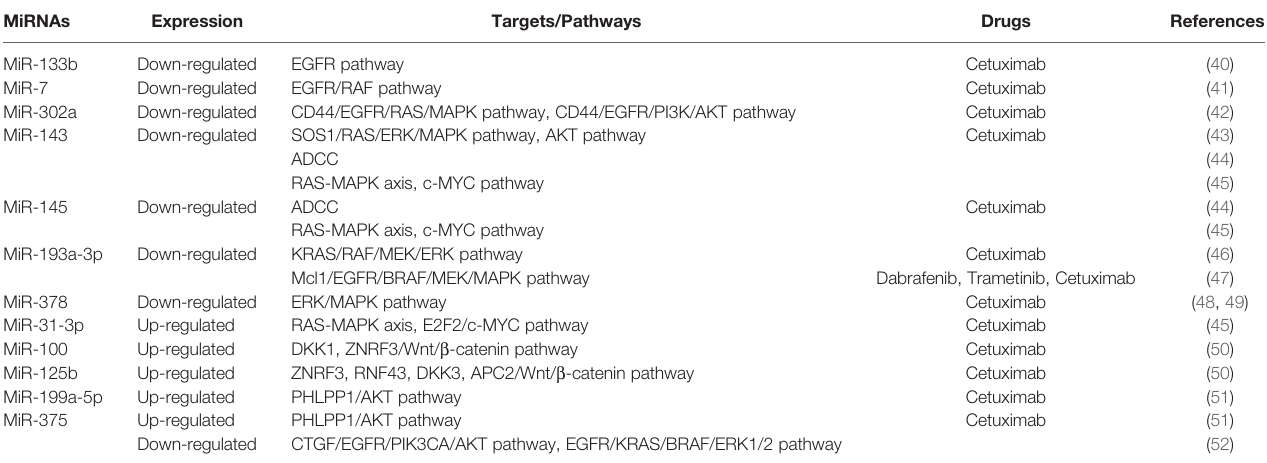
TABLE 1 | MiRNAs involved in anti-EGFR drugs resistance in CRC.